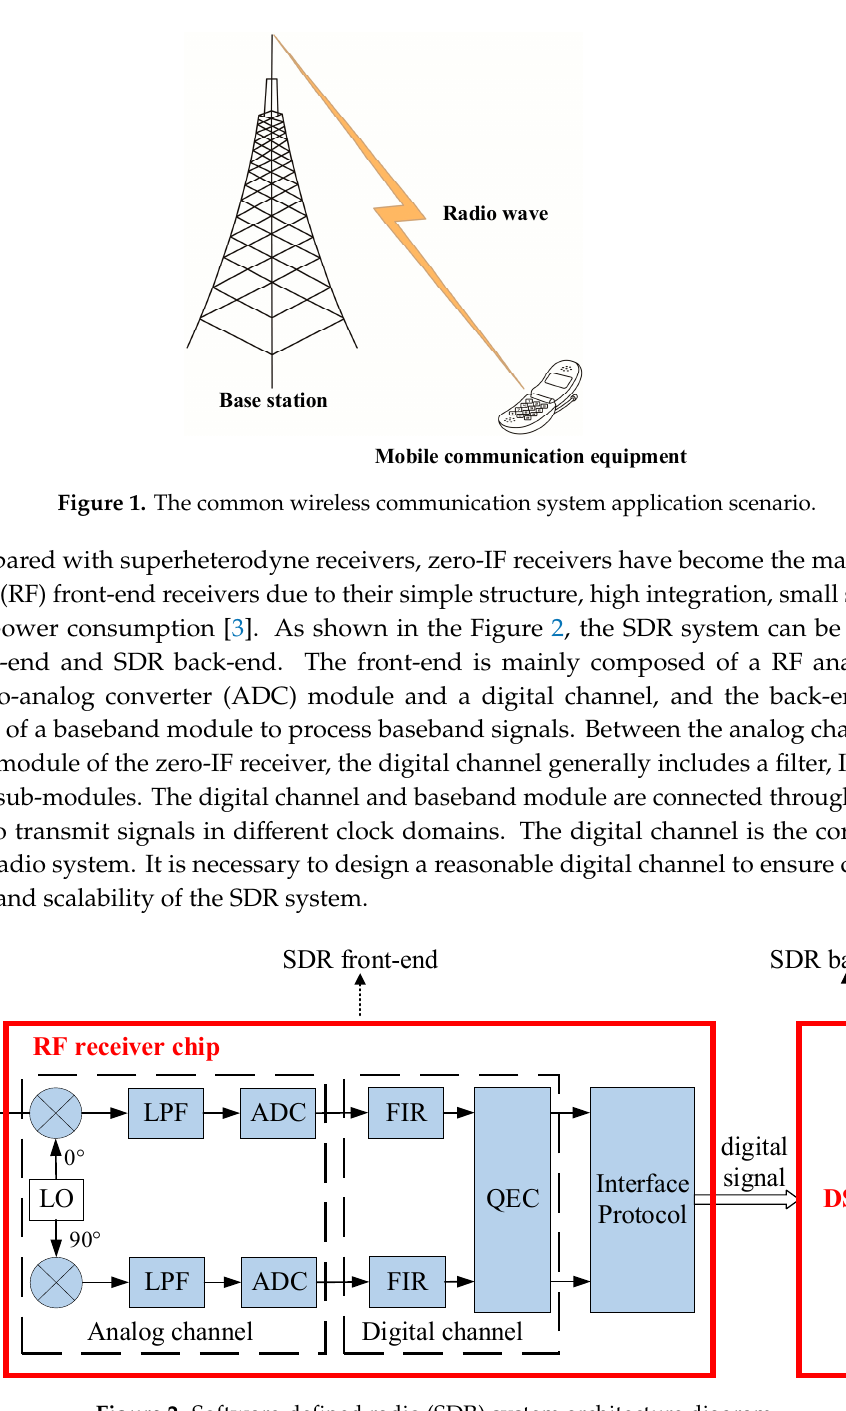
Figure 2. Software ‐ defined radio (SDR) system architecture diagram.